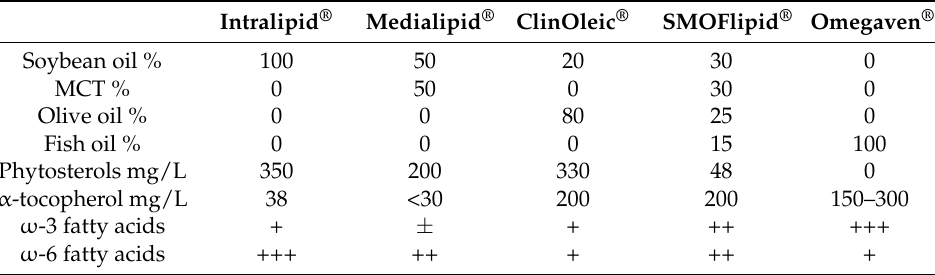
Table 1. Composition of fat emulsions for parenteral